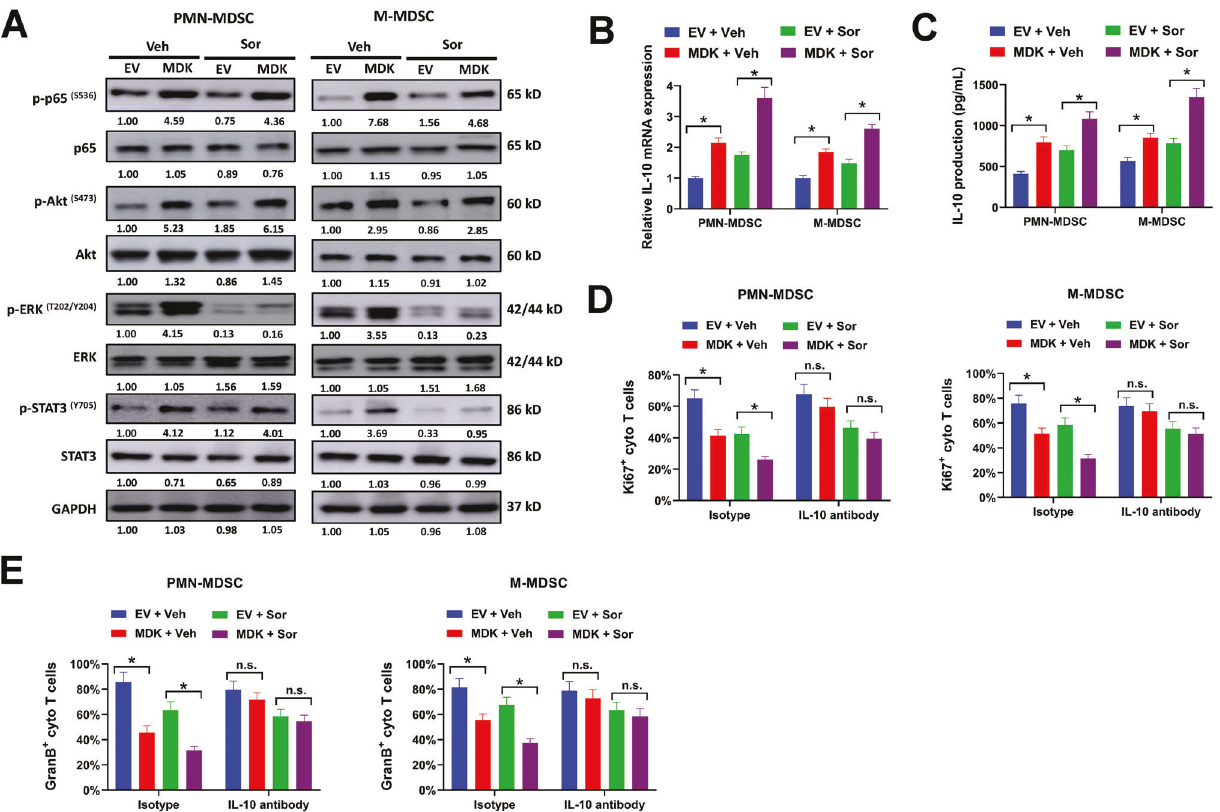
Fig. 7 Midkine overexpression promotes multiple pathways activation and IL-10 production by MDSCs. A – C PMN-MDSCs and M-MDSCs were sorted from midkine-overexpressing or EV-transduced orthotopical Hepa 1-6 tumors with/without sorafenib treatment, then collected cell lysates for western blot ( A ). Relative IL-10 expression ( B ) and production ( C ) were evaluated by qRT-PCR and ELISA assay. D , E PMN-MDSCs, and M-MDSCs sorted from midkine-overexpressing or EV-transduced orthotopic Hepa 1-6 tumors with/without sorafenib treatment were used for T-cell suppression assay. Ki67 + ( D ) and Granzyme B + ( E ) cytotoxic T cells were evaluated by fl ow cytometry. All assays were done with at least three repeats. Data were shown as mean ± s.d., * P <